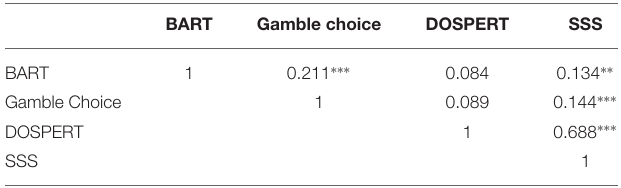
TABLE 7 | Spearman’s ρ of the correlations of risk-preference measured by four measures.